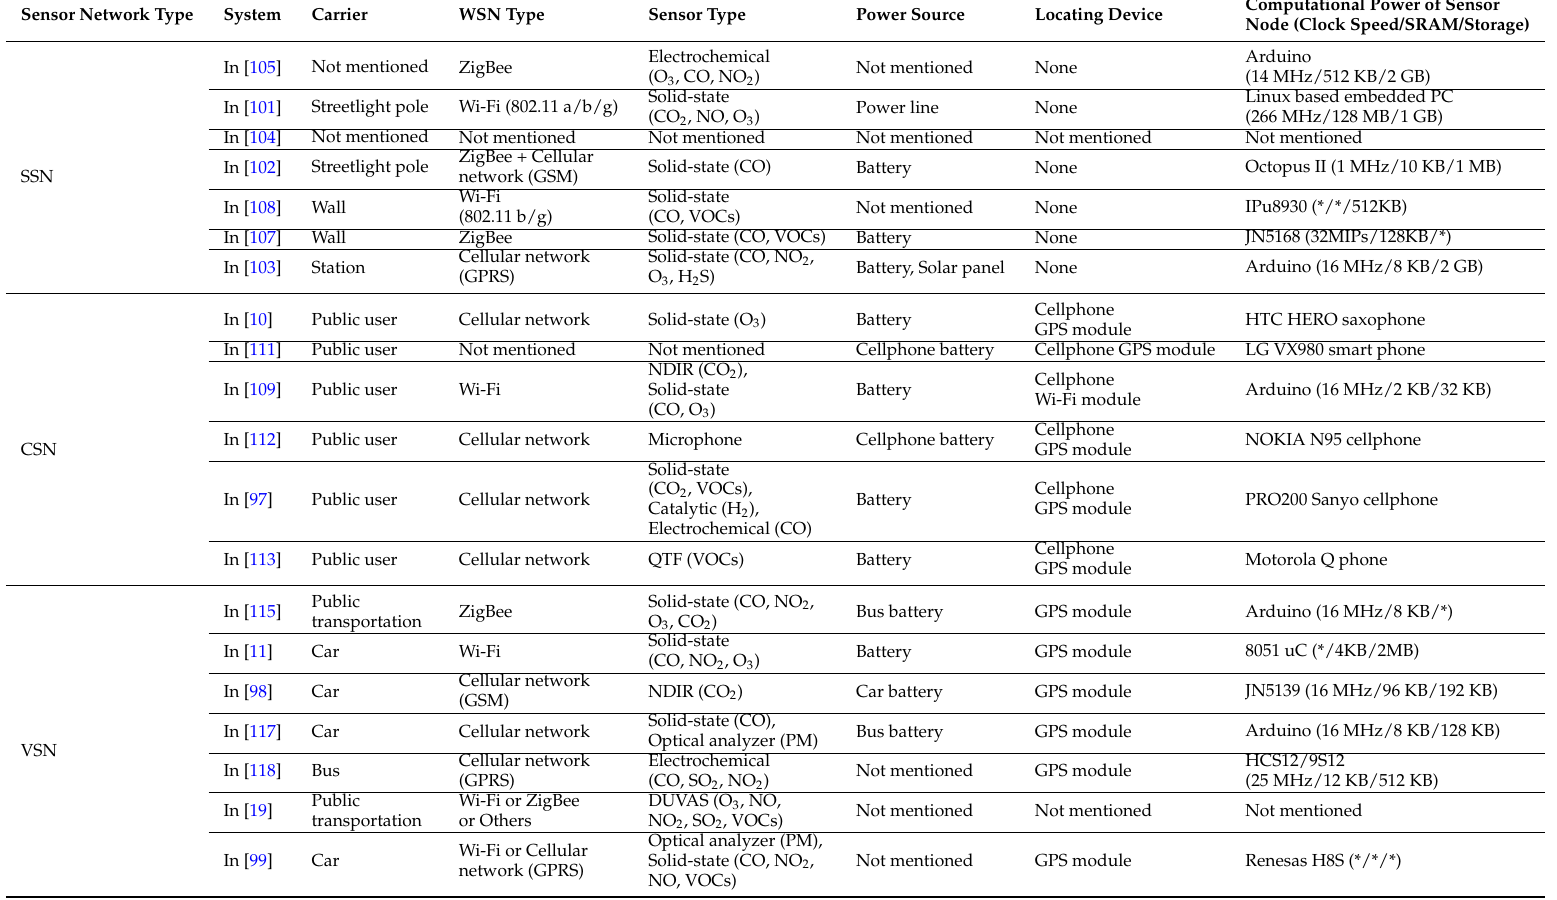
Table 9. Summary information of the 20 systems in literature works (Part A) (* means